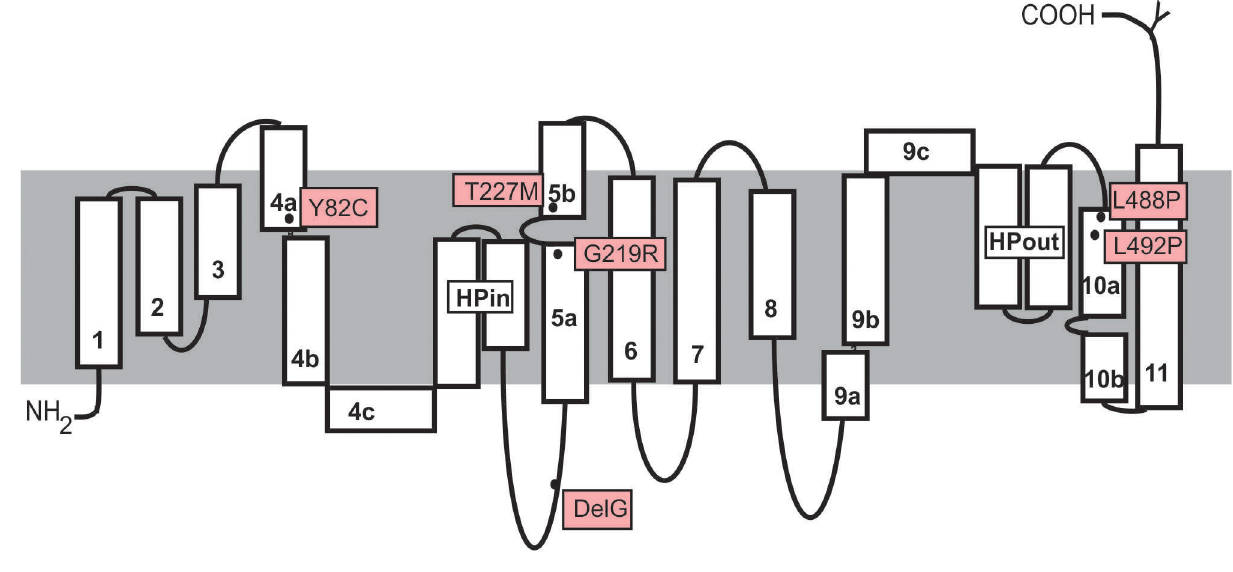
Figure 1. Secondary structure model of NaCT showing location of mutations in this study. The 11 transmembrane helices are shown as numbered rectangles and the opposing hairpin loops are labeled HP. The outside of the cell is at the top of the